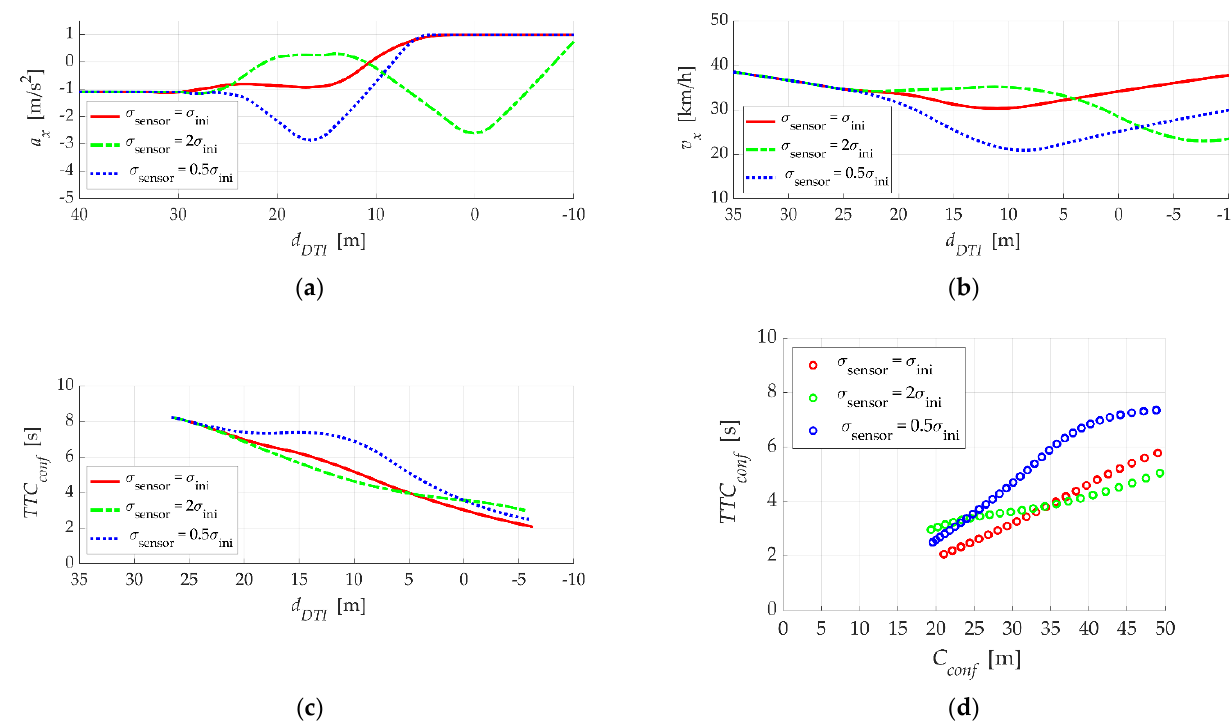
Figure 13. Simulation results of the base algorithm. ( a ) History of longitudinal acceleration; ( b ) history of longitudinal velocity; ( c ) history of TTC conf ; ( d ) trajectory of TTC conf and C conf .